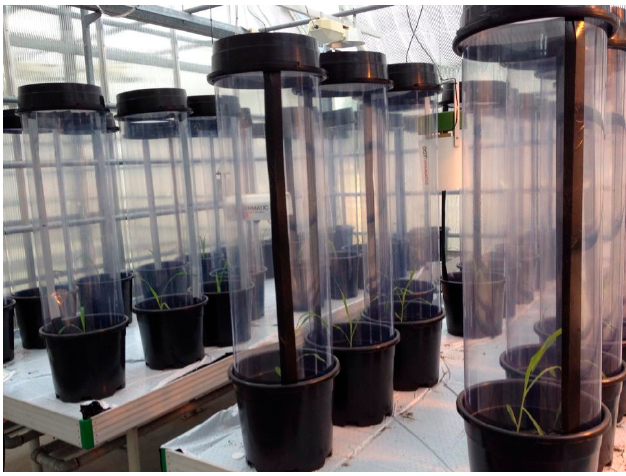
Figure 1. Experimental cages made of plastic Mylar film. Cage tops were covered with fine nylon mesh and secured with plastic rings to prevent insect escape.